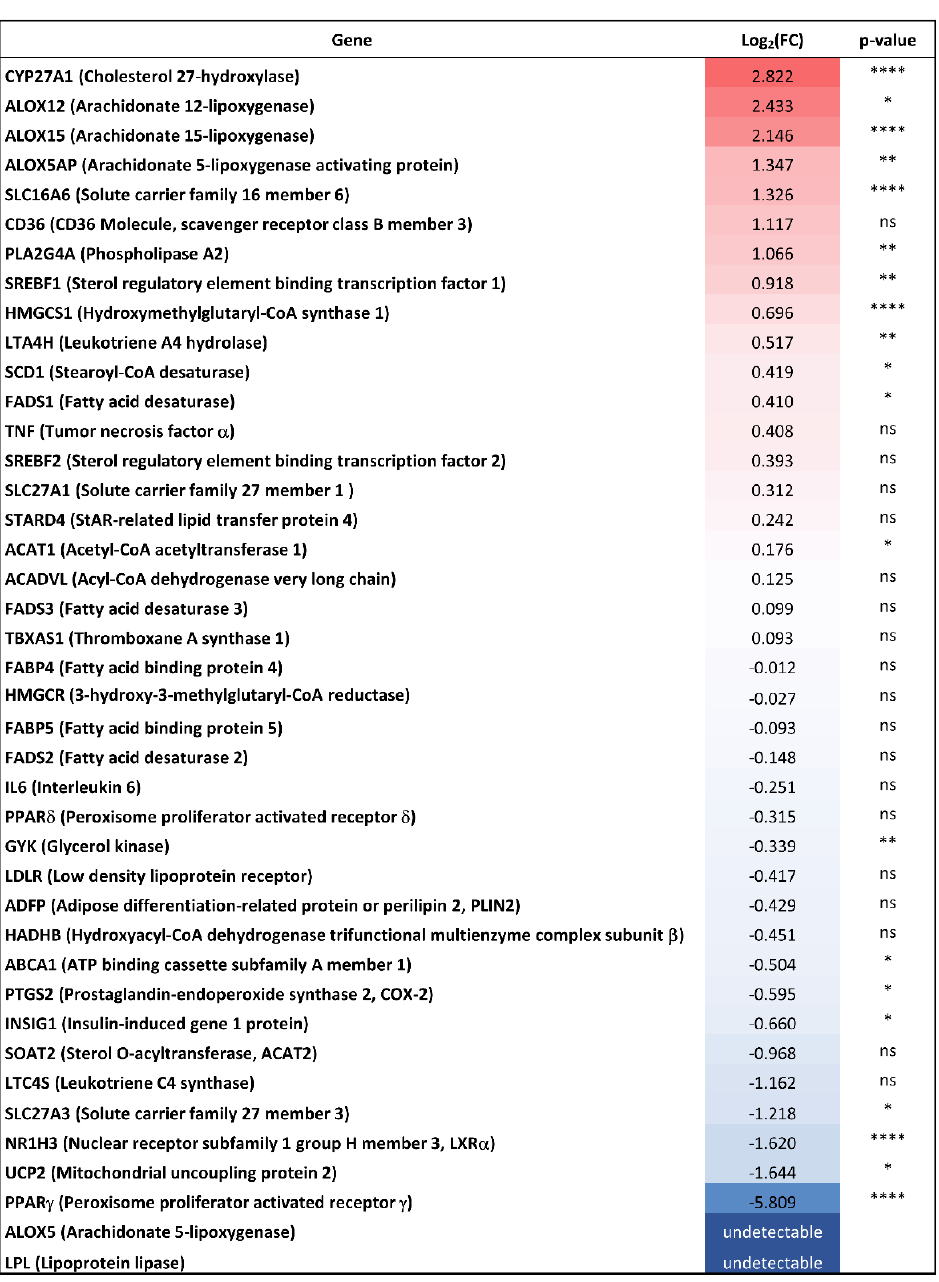
Figure 2. Gene expression analysis of lipid-related genes. Gene expression levels of 43 lipid-related genes were analysed in ApoE3 and ApoE4 immortalized mouse astrocytes by using the TaqMan Array Mouse Lipid Regulated Genes 96-well Plate. The Figure shows the expression levels of each gene in ApoE4 astrocytes (up-regulated genes: red; down-regulated genes: blue) compared to ApoE3 astrocytes. Gene expression results were normalized to the average expression levels of three endogenous control genes included in the plate: glyceraldehyde-3-phosphate dehydrogenase (GAPDH), hypoxanthine phosphoribosyltransferase 1 (HPRT1), and β -glucuronidase (GUSB). Arachinodate 5-lipoxygenase (ALOX5) and lipoprotein lipase (LPL) expression levels were undetectable in ApoE4 astrocytes, so it was not possible to calculate the Log 2 (FC) of these genes. Data are expressed as mean values of three different experiments ( n = 6 , Student’s t -test). **** p < 0.0001, ** p < 0.01, and * p < 0.05 vs. ApoE3 astrocytes; ns: not significant.